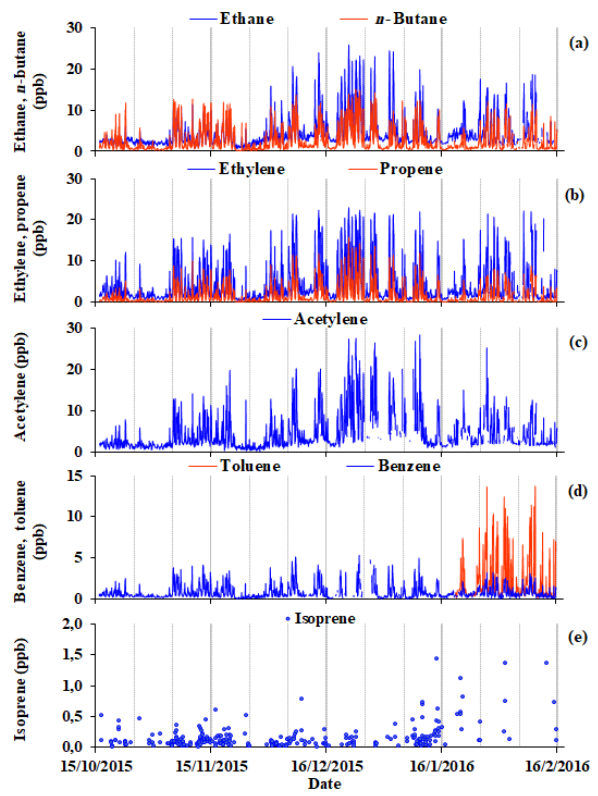
Figure 2. Temporal variability of (a) ethane and n- butane, (b) ethy- lene and propene, (c) acetylene, (d) benzene and toluene and (e) iso- prene, based on hourly averaged levels for the period from 16 Oc- tober 2015 to 15 February 2016, at the NOA urban background site in Thissio, downtown